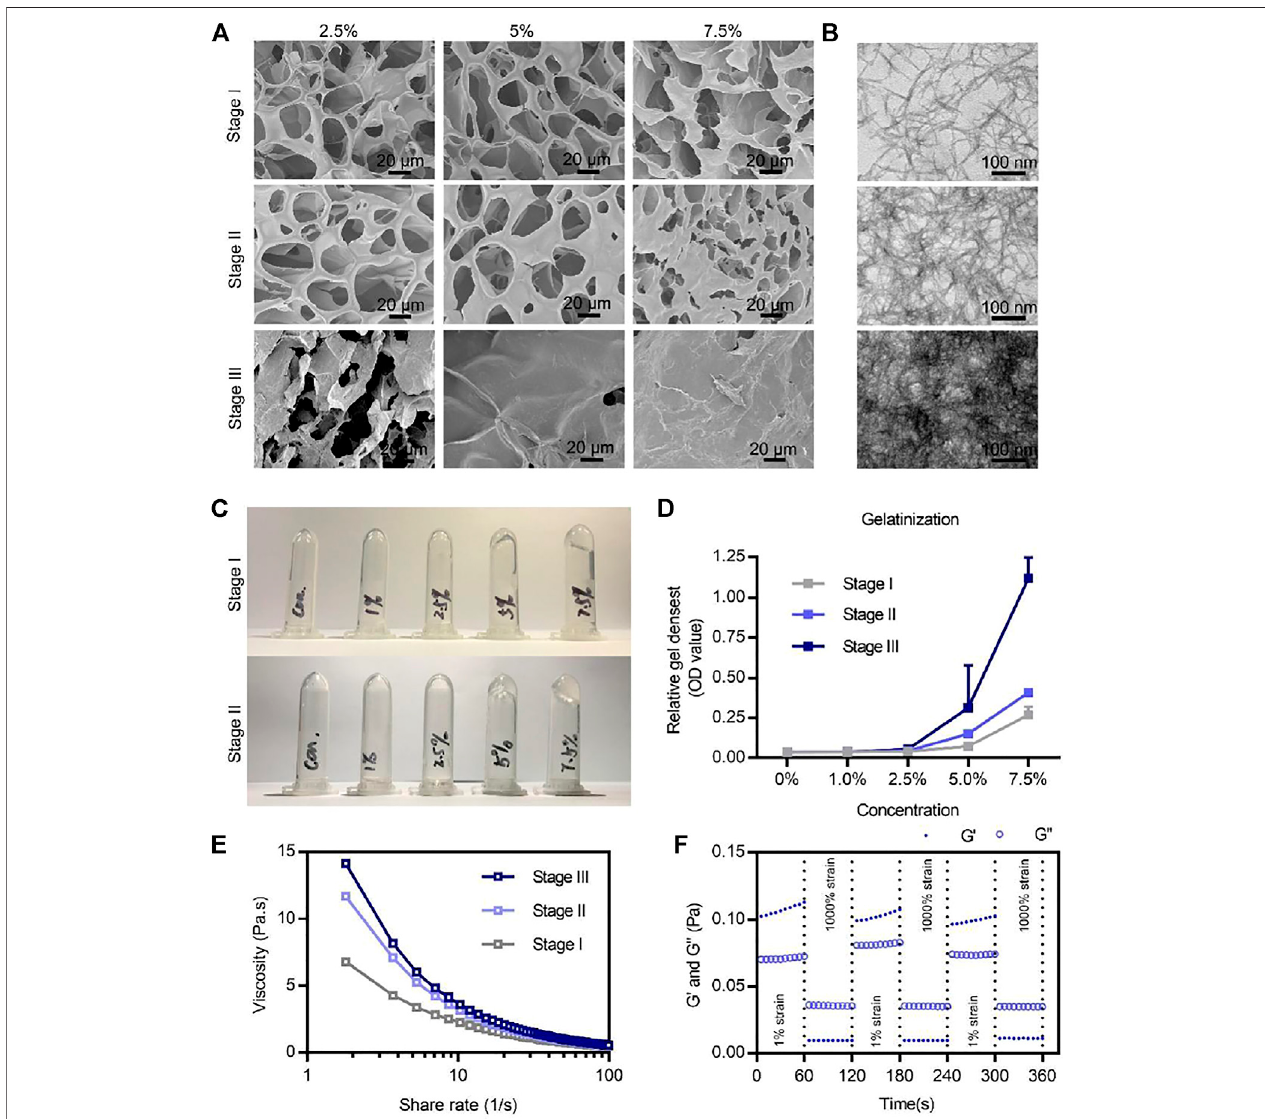
FIGURE 2 | Microstructures and physicochemical properties of the BSAP hydrogel. (A) SEM image of the three stages ’ BSAP hydrogels at different concentrations. Scale bar = 20 µm. (B) TEM image of nano fi bers of the three stages ’ BSAP hydrogels. Scale bar = 100 nm. (C) Gelatinization photography of BSAP hydrogels at stage I and stage II. (D) Gelatinization quantized at the absorbance at 600 nm ( n = 3). (E) Viscosity-shear rate pro fi les of the BSAP hydrogel with the shear rate ranging from 0.01 to 100 s − 1 ( n = 3). (F) The shear recovery property of the BSAP hydrogel when alternating the strain from 1 to 1,000% periodically ( n = 3).